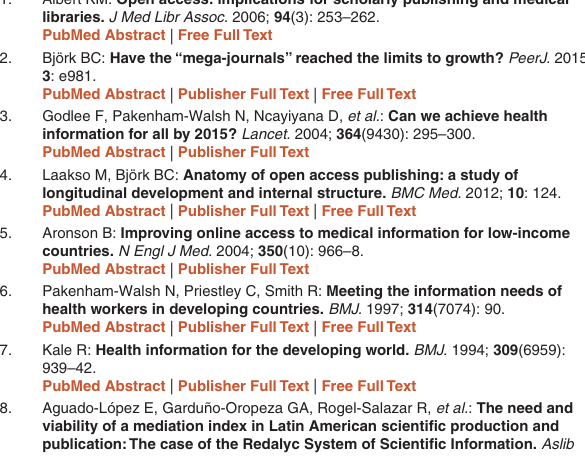
Referencia): América Latina pasa la primera página en Acceso Abierto . Red Clara & Banco Interamericano de Desarrollo, [Last accessed on 2015 Dec